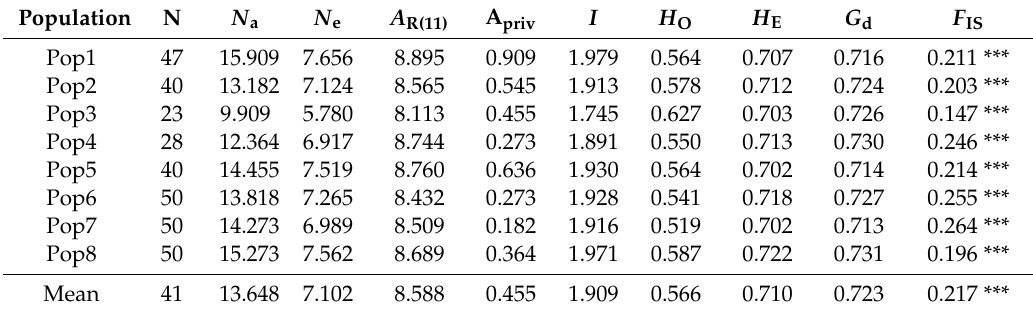
Table 6. Genetic diversity parameters 1 for the studied Norway spruce stands from BPF. Population codes are given in Table 2.